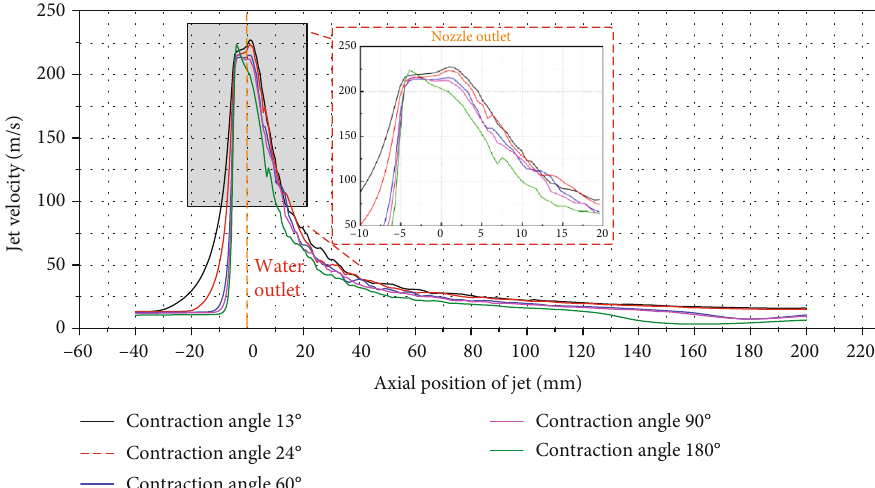
Figure 9: Variations of jet velocity on the jet axis under di ff erent contraction